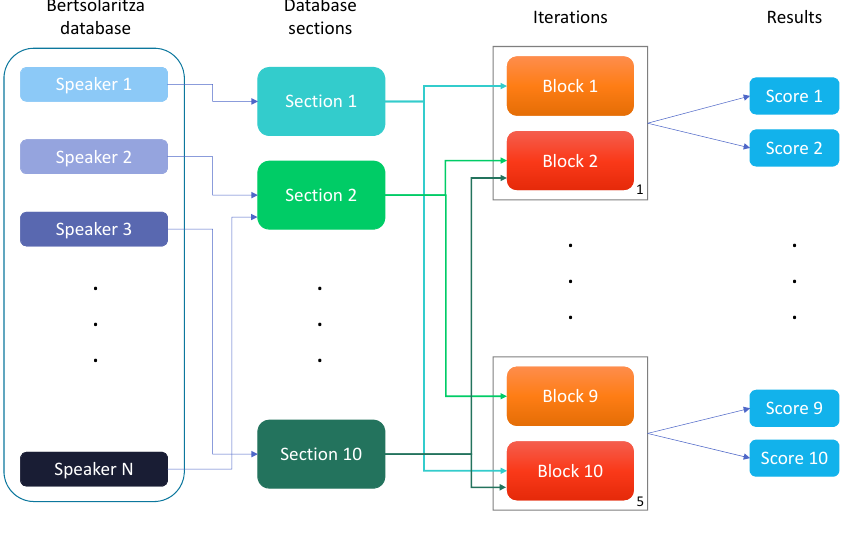
Figure 9. 5x2cv test